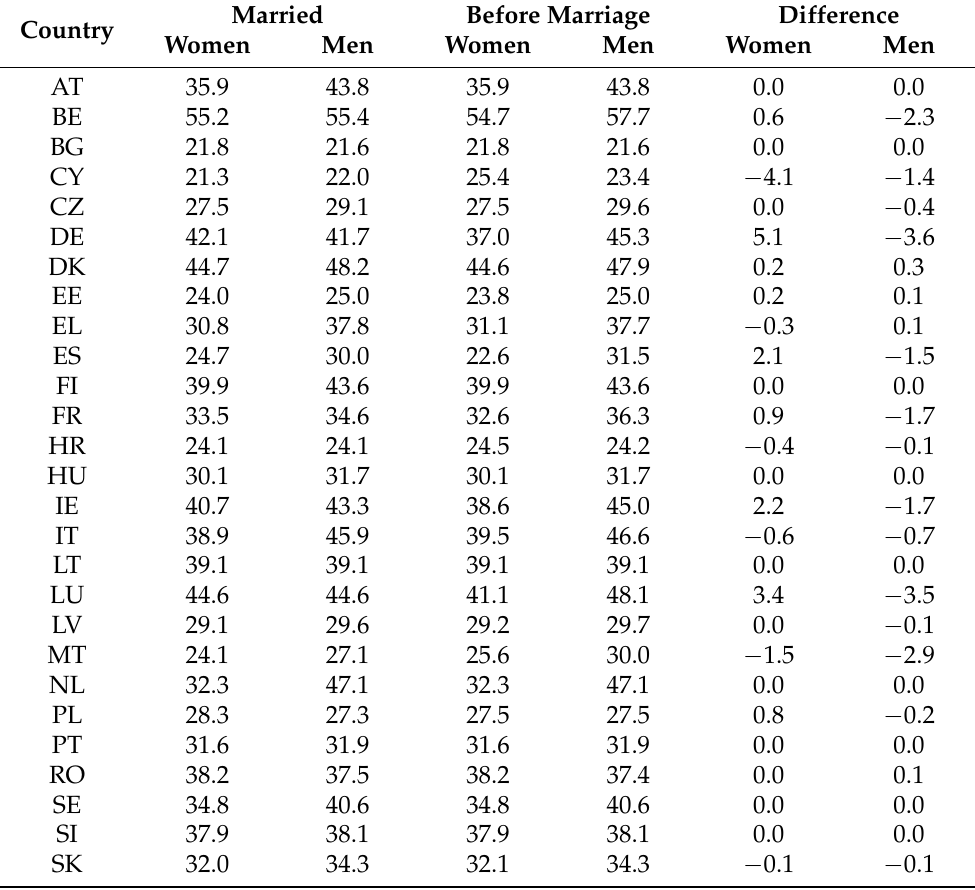
Table A3. The average METR before and after marriage for all EU